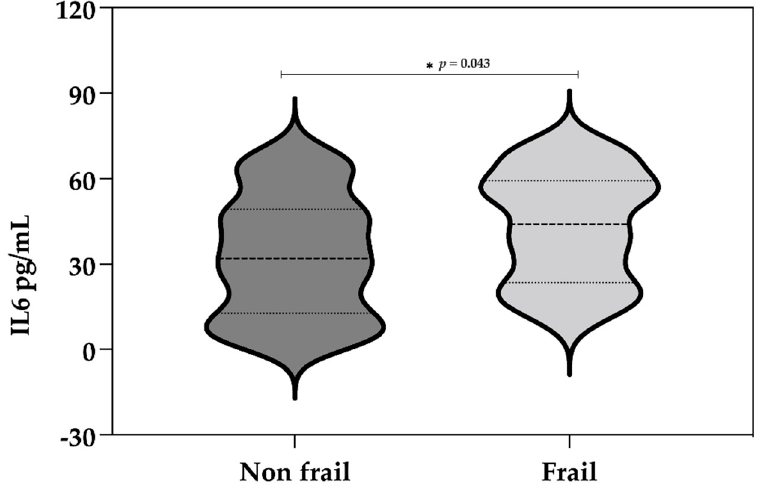
Figure 2. Difference between frailty syndrome and IL-6 (pg/mL). Robust and pre-frail patients were grouped into the non-frail group. Frail patients were those who met 3 or more of the frailty criteria. For each of the frailty criteria, there were significant differences in IL-6 between those who did not ( p = 0.007, Mann–Whitney U) (Figure 3A). Regarding the frailty criterion “Involuntary weight loss” there was a significant difference in salivary IL-6 concentration between the individuals that fulfilled this criterion compared to those did not ( p = 0.002, Mann–Whitney U) (Figure 3B). Figure 3. ( A ) Difference between physical activity frailty criteria and ( B ) IL-6 (pg/mL) and weight loss frailty criteria and IL-6 (pg/mL). In order to analyze the sensitivity and the specificity of salivary IL-6 concentration to discriminate frail versus non frail (robust) individuals, we performed the receiving operating curve (ROC) analysis (Figure 4). The area under the curve value was 0.697 with 95% CI (0.566–0.827) and the cut-off value 3.74 pg/mL has a sensitivity of 69.0% and a specificity of 52.8%.